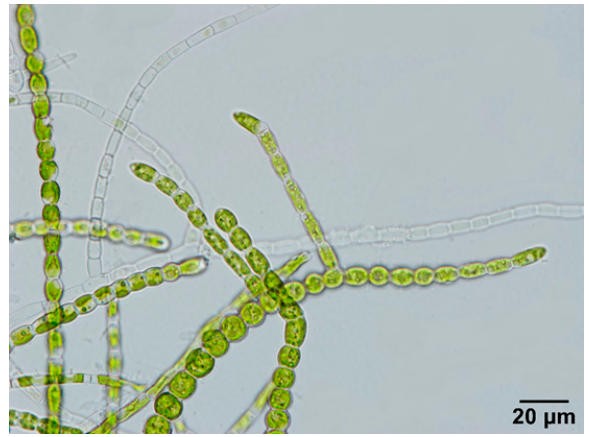
Figure 1. Optical image of Stigeoclonium sp. B23.